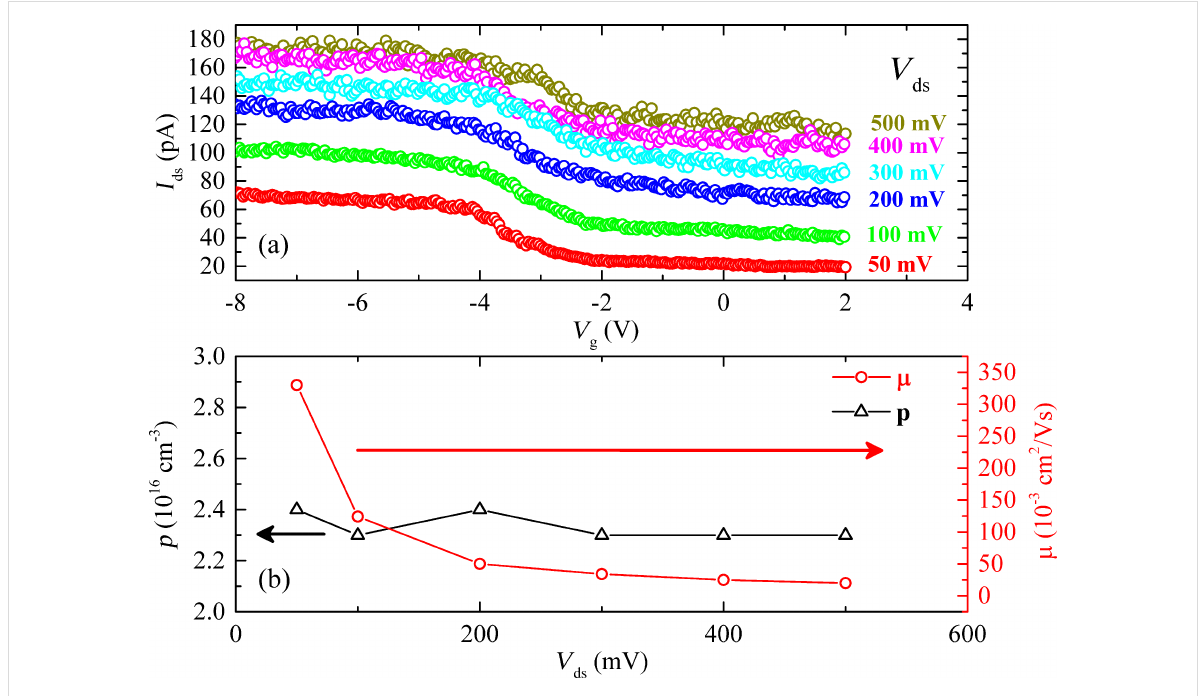
Figure 4: (a) p-type characteristic curves I ds – V g of a FET based on the Mg-doped single GaAs nanowire #1 grown on GaAs(111)B substrate, as a function of V ds and measured at 300 K. (b) Free carrier density and field mobility variation with V ds in the FET nanowire.